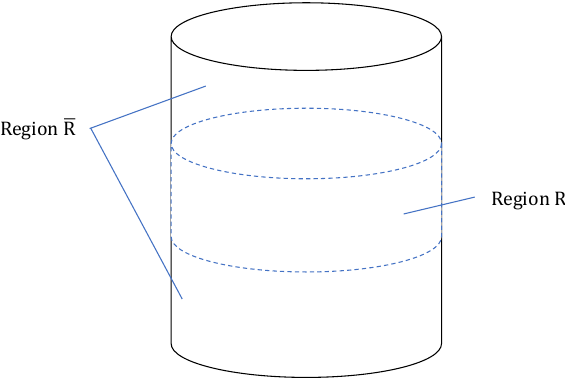
Figure 6 . A horizontal strip wrapping the